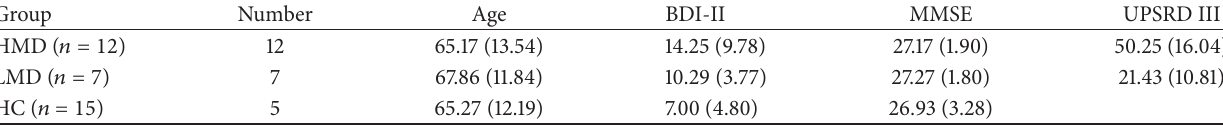
Table 3: Means (standard deviations) for demographic and clinical characteristics of PD patients and healthy controls in Experiment 2.